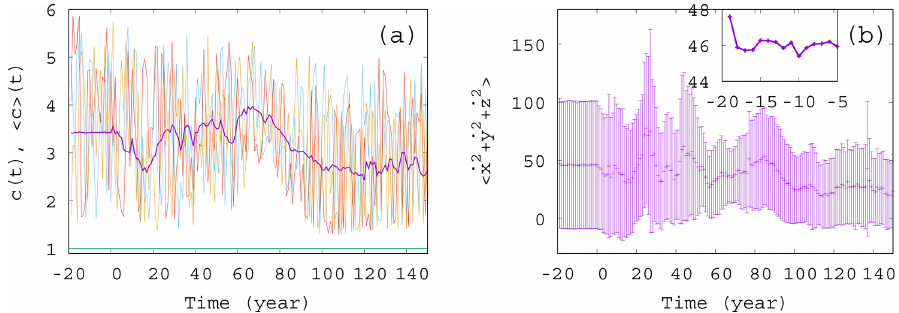
Figure 2. Ensemble properties before ( t < 0) and after ( t > 0) the onset of climate change. (a) Phytoplankton concentration c as a function of time for three random initial conditions in different colors for α = 0 . 05, β = 0 . 1, and γ = 0 . 1. The purple line is the ensemble average < c > ( t ) for 50000 trajectories started with random initial positions in the range x ∈ [− 0 . 5 , 3 ] ; y,z ∈ [− 2 . 5 , 2 . 5 ] ; and c ∈ [ 0 . 9 , 1 . 1 ] at year − 20. The green line (close to c = 1) shows the expected phytoplankton concentration without any mixing ( γ = 0) as predicted by Eq. (10). (The increase for t > 0 is so weak that one hardly recognizes it on this graph.) (b) Time dependence of the ensemble average (dark violet “ + ” marks) of the total atmospheric kinetic energy < ˙ x 2 + ˙ y 2 + ˙ z 2 > for the same ensemble as the one used for c in panel (a) . Violet bars indicate the standard deviation. The inset shows the blowup of the initial part of the average in panel (b) .